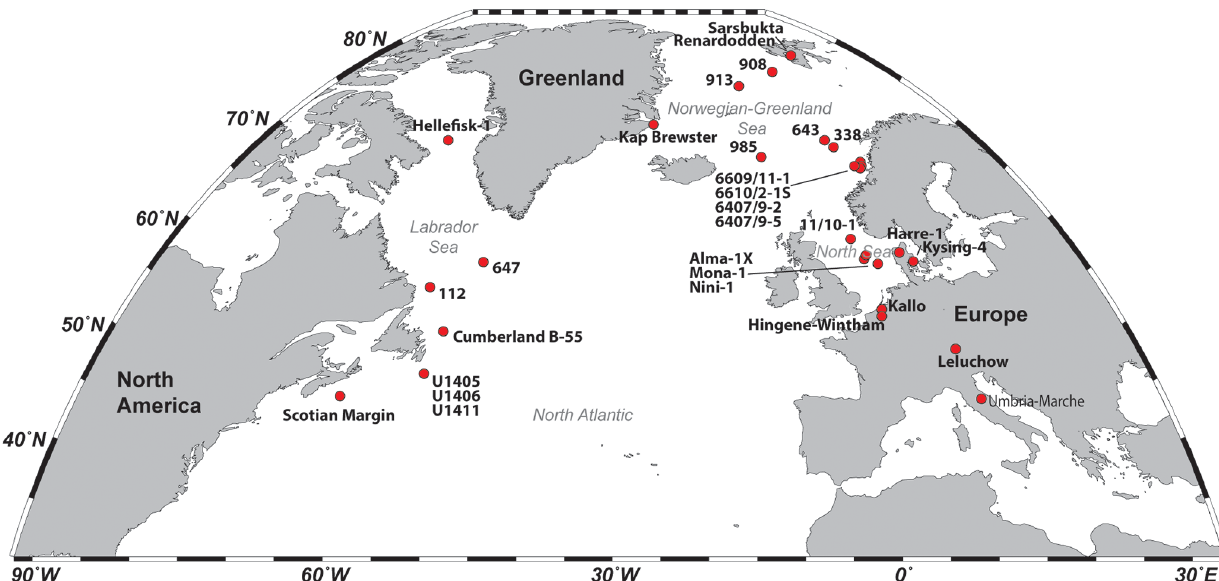
Figure 1. The distribution of drill sites and outcrops where Svalbardella specimens have been reported (see Table 1). Modified from Egger et al. (2016). Reprinted from Review of Palaeobotany and Palynology, 234, Egger, L. M., ´Sliwi´nska, K. K., van Peer, T. E., Liebrand, D., Lippert, P. C., Friedrich, O., Wilson, P. A., Norris, R. D., and Pross, J.; Magnetostratigraphically-calibrated dinoflagellate cyst bioevents for the uppermost Eocene to lowermost Miocene of the western North Atlantic (IODP Expedition 342, Paleogene Newfoundland